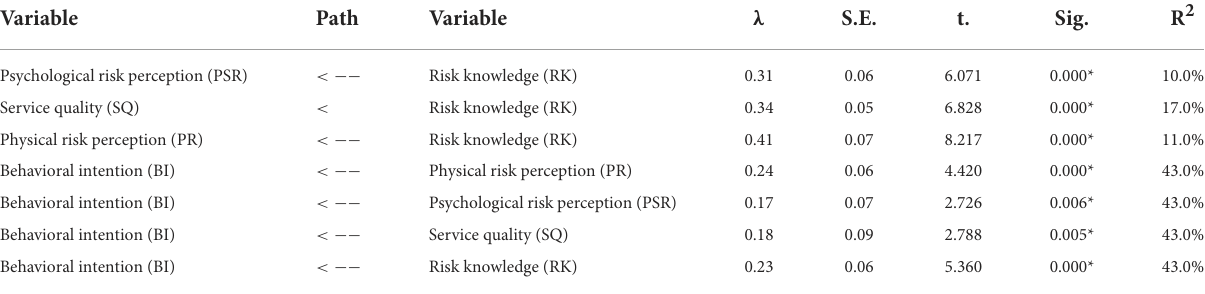
TABLE 7 Analysis statistics of the structural equation modeling analysis of risk knowledge pathways to behavioral intention of air travel risk perception during COVID-19.